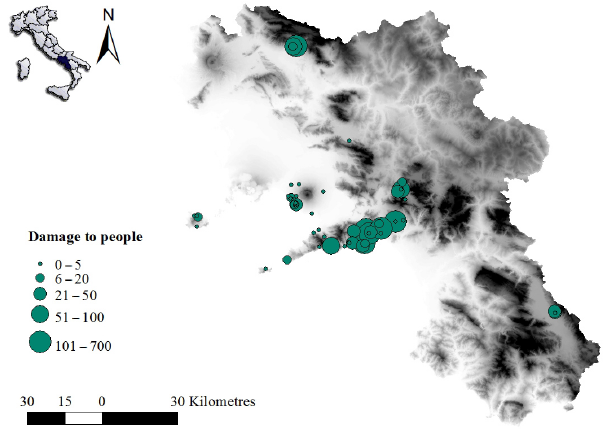
Figure 12. Distribution of victims recorded in the